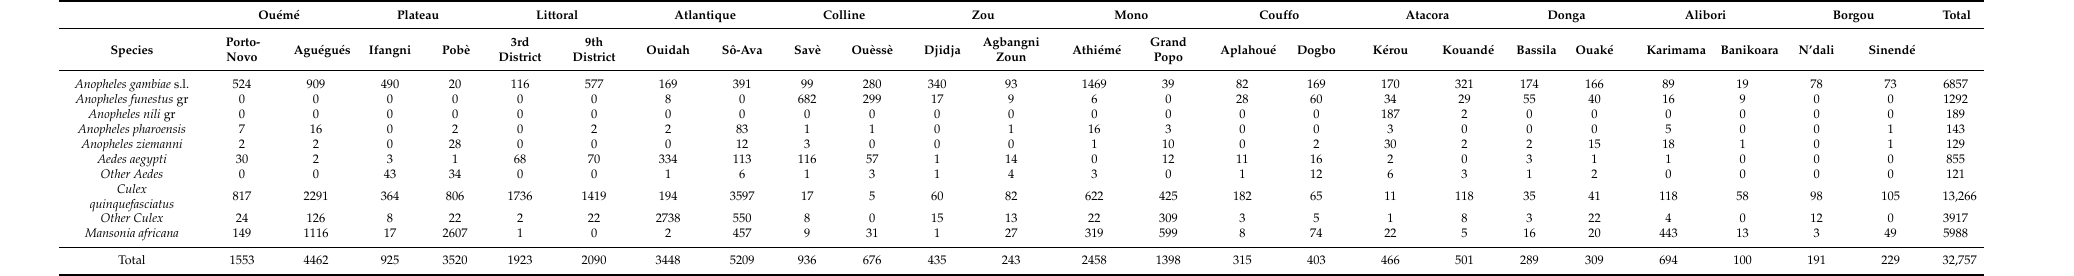
Table 2. Culicidae diversity and abundance in the departments of Benin from April to December